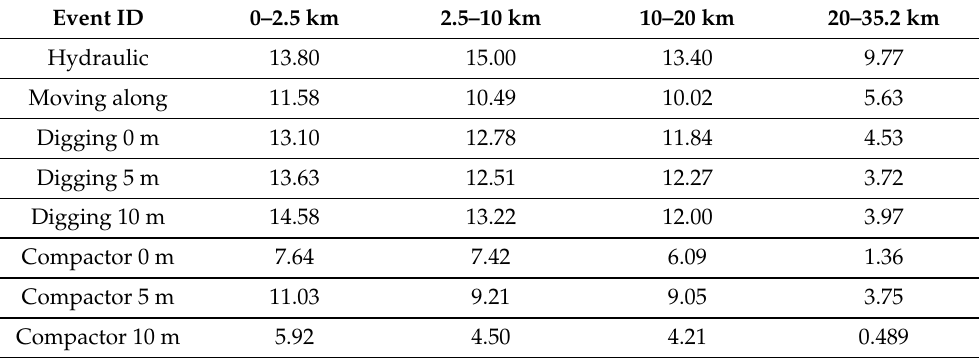
Table 3. ∆ SNR (dB) for different events and